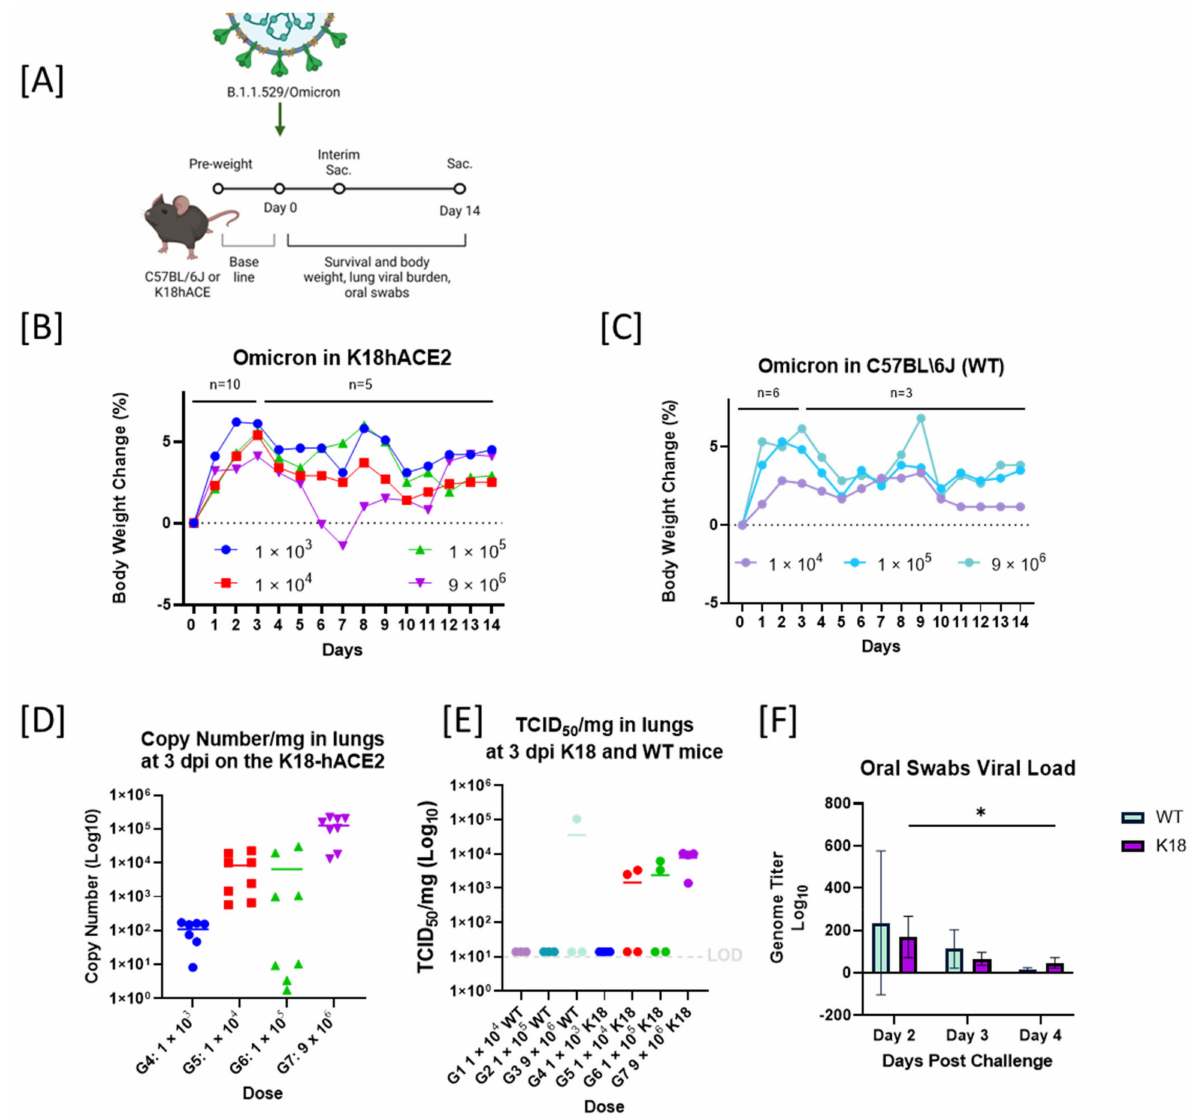
Figure 3. Reduced pathogenicity in B.1.1.529/Omicron (BA.1)-infected mice. ( A ). Schematic diagram of SARS-CoV-2 infection and the experimental design. Created with BioRender.com. Animals were intranasally inoculated with 9 × 10 6 , 1 × 10 5 , 1 × 10 4 , or 1 × 10 3 , in K18-hACE2 mice and 9 × 10 6 , 1 × 10 5 , 1 × 10 4 in C57BL \ 6J. of B.1.1.529 variant of SARS-CoV-2 on day 0. Body weights before challenge were used to establish baseline. Survival, body weight, and oral swabs were observed or collected daily. Lungs were collected at the interim and terminal euthanasia. ( B ) Percentage of body weight changes (BWC) in K18-hACE2 mice inoculated with 9 × 10 6 , 1 × 10 5 , 1 × 10 4 , or 1 × 10 3 . All groups started with n = 10, n = 5 were scheduled for interim euthanasia at 3 dpi. From 4 dpi to 14 dpi, n = 5. ( C ) Percentage of BWC in WT mice (C57BL \ 6J) inoculated with 9 × 10 6 , 1 × 10 5 or 1 × 10 4 . All groups started with n = 6, and n = 3 were scheduled for interim euthanasia at 3 dpi. From 4 dpi to 14 dpi, n = 3. ( D ) Viral load as RNA genome copy number per mg of lung tissue of K18-hACE2 mice infected with 9 × 10 6 , 1 × 10 5 , 1 × 10 4 , or 1 × 10 3 of B.1.1.529 SARS-CoV-2 after 3 dpi ( n = 4 in technical duplicates). ( E ) Viral load by TCID 50 assay in all WT and K18-hACE2 mice infected with B.1.1.529. ( F ) Virus shedding as viral genome copy number (by RT-qPCR) in oral swabs taken at 2, 3, and 4 dpi of K18-hACE2 and WT mice intranasally inoculated with 9 × 10 6 TCID 50 /animal (groups 3 and 7 only). Asterisk (*) represent statistical differences by ANOVA p ≤